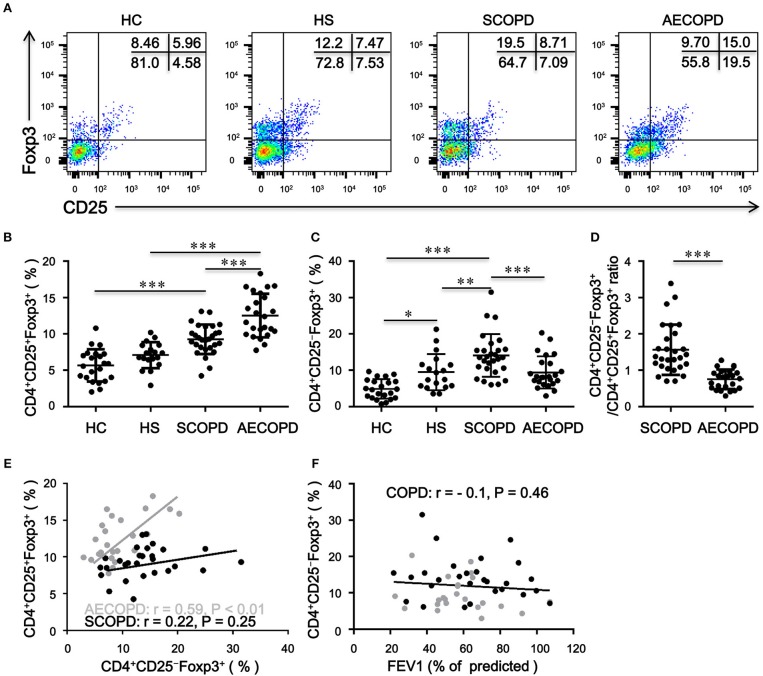
Frequency of circulating CD4+CD25–Foxp3+ T cells and CD4+CD25+Foxp3+ T cells in patients with chronic obstructive pulmonary disease (COPD). (A) Representative flow cytometric dot plots of CD4+CD25–Foxp3+ T cells and CD4+CD25+Foxp3+ T cells within CD4+ T cells in healthy controls (HC), healthy smokers (HS), stable COPD patients (SCOPD), and patients with acute exacerbation of COPD (AECOPD). Comparisons of CD4+CD25−Foxp3+ T cell (B) and CD4+CD25+Foxp3+ T cell (C) percentages in peripheral blood from HC (n = 22), HS (n = 18), SCOPD (n = 28), and AECOPD (n = 24) patients. Horizontal bars indicate means ± SD. (D) Comparisons of ratios of CD4+CD25−Foxp3+ T cells/CD4+CD25+Foxp3+ T cells in peripheral blood from SCOPD (n = 28) and AECOPD (n = 24). (E) and (F) Correlation of the percentages of CD4+CD25−Foxp3+ T cells with the percentages of CD4+CD25+Foxp3+ T cells and FEV1 (% of predicted) in COPD patients; each symbol represents an individual SCOPD patient (black dots) or AECOPD patients (gray dots). Correlations were determined by Spearman‘s rank correlation coefficients. The comparisons were determined by one-way ANOVA followed by Bonferroni‘s multiple comparison test (B,C) or two-tailed unpaired t-test (D), *P < 0.05, **P < 0.01, ***P < 0.001.